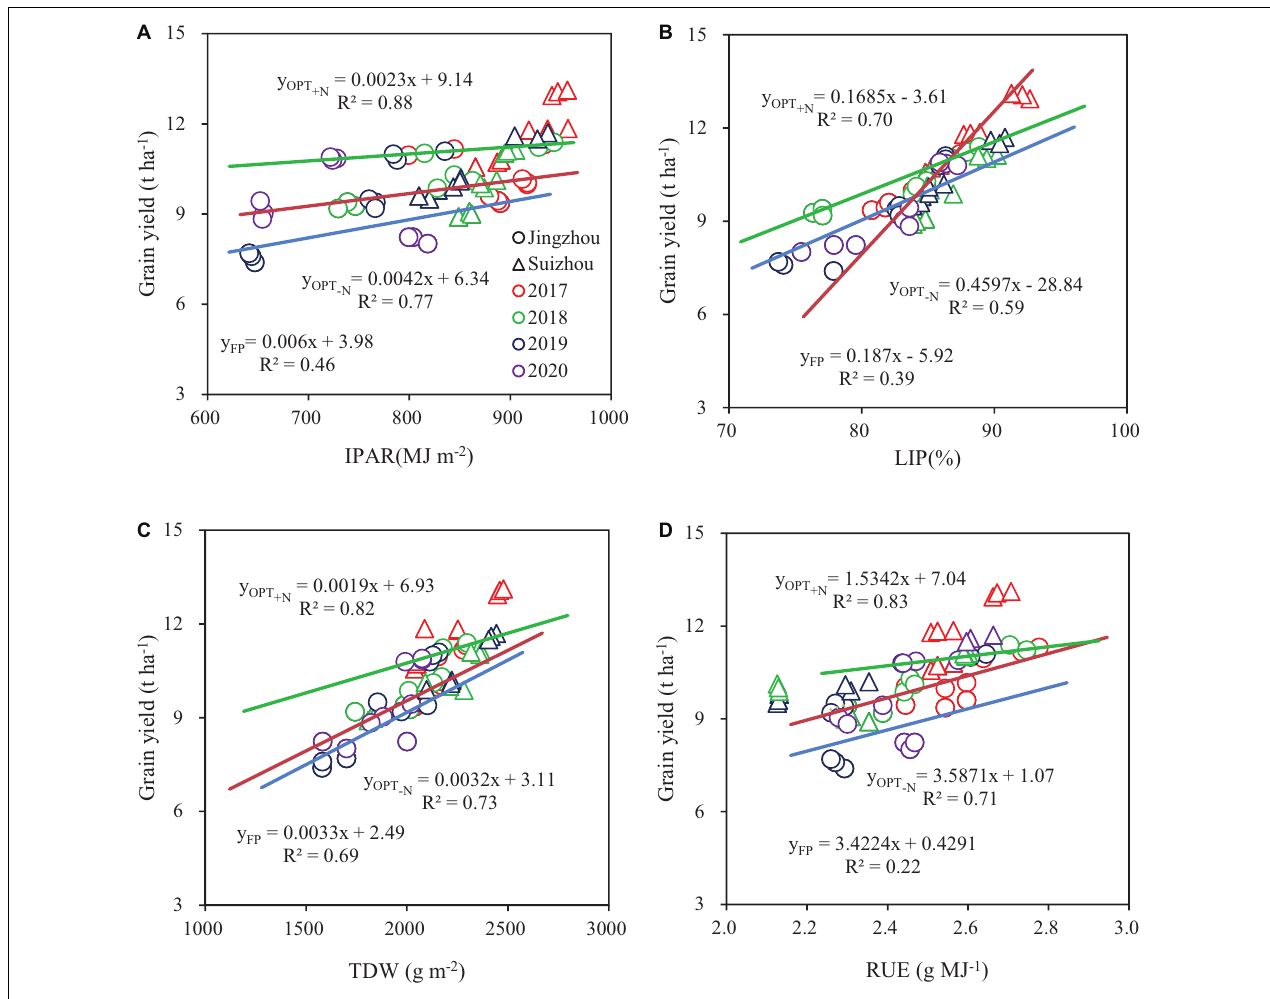
FIGURE 2 | Relationship between grain yield and intercepted photosynthetically active radiation (IPAR) (A) , light interception percentage (LIP) (B) , aboveground total dry weight (TDW) (C) , and radiation use efficiency (RUE) (D) . Colors and point symbols represent different years and sites,